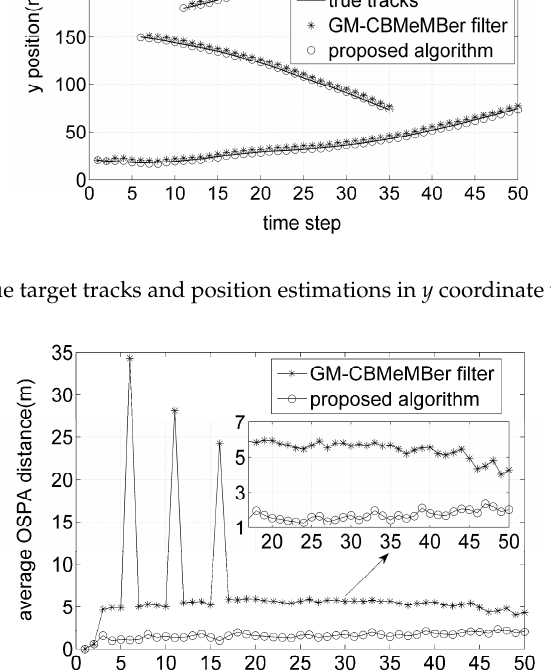
Figure 4. True target tracks and position estimations in y coordinate versus time.